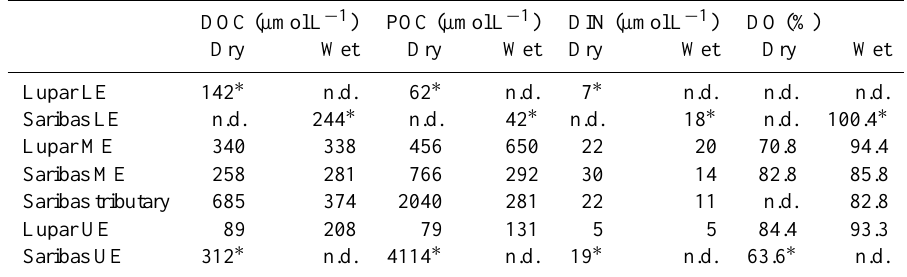
Table 1. Dissolved organic carbon (DOC), particulate organic carbon (POC) and dissolved inorganic nitrogen (DIN) median concentrations and oxygen saturation in the Lupar and Saribas estuaries.